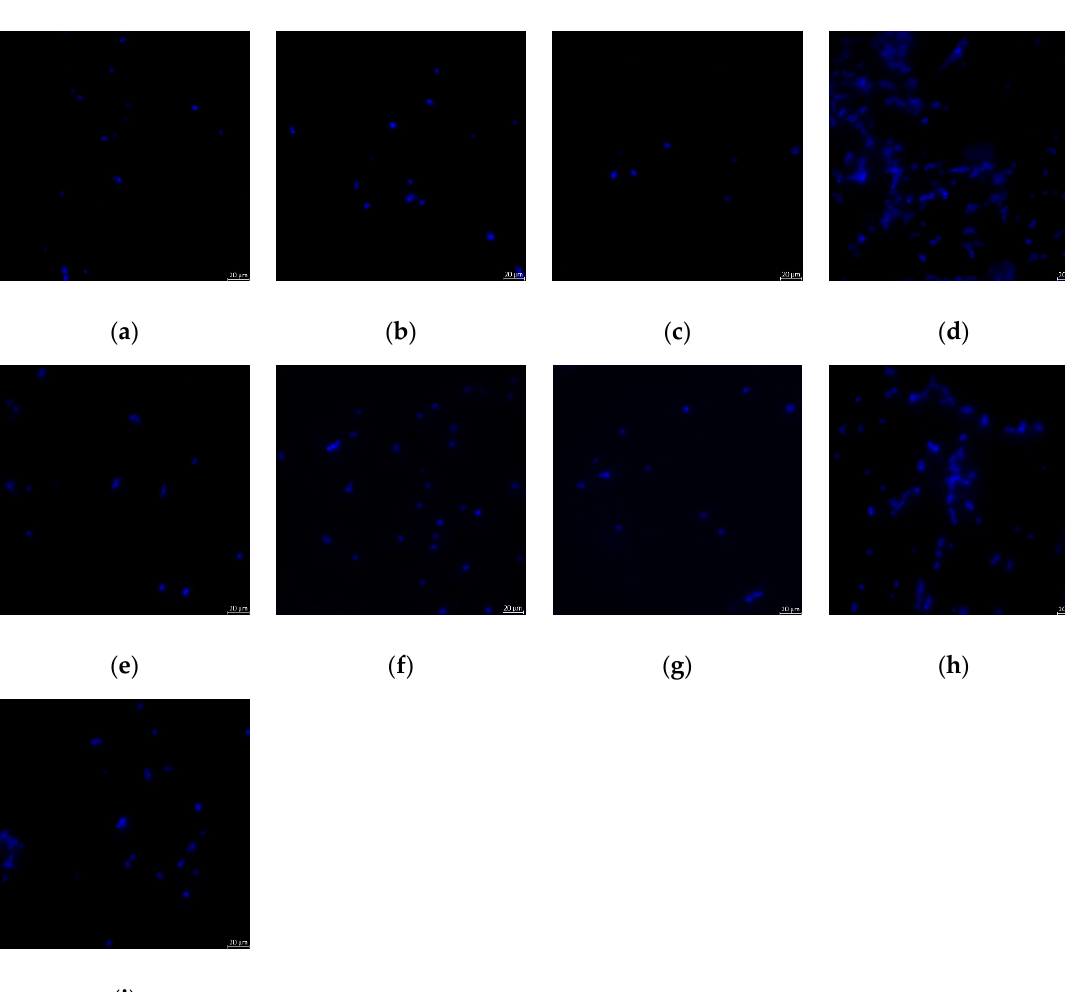
Figure 3. Exemplary epifluorescence microscopic images of C. albicans cells on specimens in each group: ( a ) PMMA + CS-G 0.1%, ( b ) PMMA + CS-G 0.3%, ( c ) PMMA + CS-G 1%, ( d ) PMMA + CS-G 3%, ( e ) PMMA + CS-HCl 0.1%, ( f ) PMMA + CS-HCl 0.3%, ( g ) PMMA + CS-HCl 1%, ( h ) PMMA + CS-HCl 3%, ( i ) PMMA (control); polymethylmethacrylate (PMMA), chitosan glutamate (CS-G), chitosan-hydrochloride (CS-HCl).